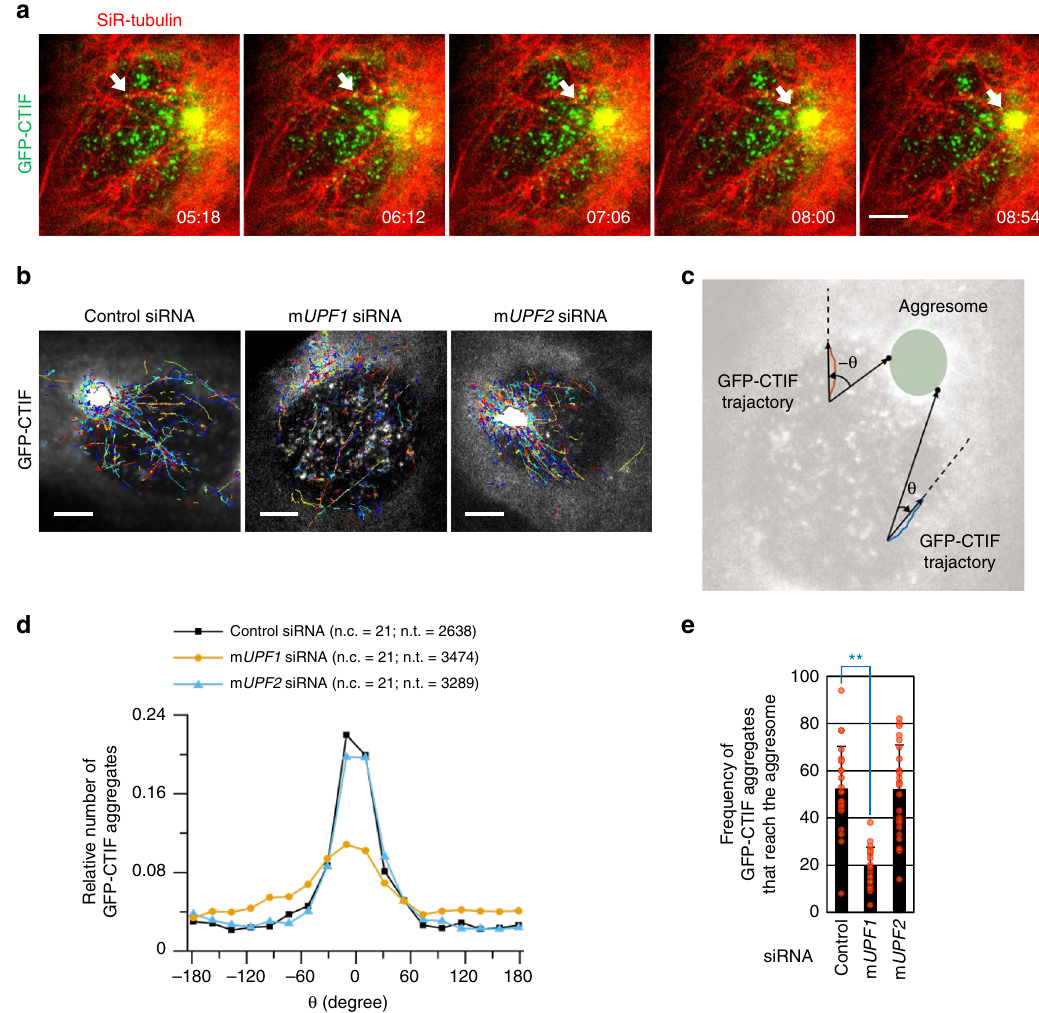
Fig. 6 UPF1 increases the frequency and fi delity of movement of CTIF aggregates. a Live cell imaging of GFP-CTIF (green) with SiR-conjugated tubulin (red). MEFs were transiently transfected with GFP-CTIF and were treated with SiR-tubulin for staining of microtubules. Then, the cells were visualized by line-scan confocal microscopy. Scale bar, 5 μ m; n = 3. b GFP-CTIF aggregates moving toward the aggresome after downregulation of mouse (m) UPF1 or mUPF2. MEFs were transfected with m UPF1 siRNA, m UPF2 siRNA, or nonspeci fi c control siRNA. One day later, the cells were transiently transfected with GFP-CTIF. Two days later, the cells were treated with MG132 and visualized by line-scan confocal microscopy. The trajectories of individual GFP-CTIF aggregates that moved over 590 nm are depicted. Scale bar, 5 μ m; n = 3. c The degree of the migration direction of individual GFP-CTIF aggregates with respect to the aggresome. We fi rst determined the brightest position corresponding to the aggresome periphery closest to the GFP-CTIF aggregates of interest. Then, we measured the angle between the linear trajectory of the GFP-CTIF and a line connecting the brightest position with the initial point of the trajectory of GFP-CTIF. d The distribution of the observed angle values of individual GFP-CTIF aggregates. The number of the cells at each angle was normalized to the total number of the cells analyzed. The number of cells (n.c.) were 21 from three independent experiments for all cases and the number of trajectories (n.t.) were 2638 (Control siRNA), 3474 (m UPF1 siRNA), and 3289 (m UPF2 siRNA), respectively. e The frequency of GFP-CTIF aggregates that reach the aggresome. The number of GFP-CTIF aggregates (per cell) that reached the aggresome during 15 s were counted. Data are presented as mean values ± SD. Two-tailed, unequal-sample variance Student ’ s t test was carried out to calculate the P values. ** P < 0.000. The exact P values are provided in a Source Data File; n = 23 (Control siRNA), 22 (m UPF1 siRNA), and 25 (m UPF2 siRNA) cells from three independent experiments were examined; Source data are provided as a Source Data number of migrating GFP-CTIF aggregates at the same time, we (Fig. 6e), without affecting the translocation rate (Supplementary de fi ned the degree of directional motion of GFP-CTIF aggregates Fig. 11b). Of note, neither mUPF1 nor mUPF2 downregulation toward the aggresome as an angle ( θ ) between the direction of affected the organization of microtubule and MTOC, whereas movement of the GFP-CTIF aggregates and the location of the treatment with the microtubule-depolymerizing drug nocodazole aggresome periphery (Fig. 6c). The results revealed that the almost completely disrupted microtubule organization without distribution of the angle values was drastically spread out in the affecting MTOC (Supplementary Fig. 12). Thus, taken together, mUPF1-depleted cells, in comparison with undepleted or these results suggest that UPF1 promotes the formation of mUPF2-depleted cells (Fig. 6d). Furthermore, downregulation aggresome containing misfolded polypeptides at two distinct of mUPF1, but not mUPF2, signi fi cantly decreased the frequency steps: it facilitates ef fi cient formation of the CED complex of movement of GFP-CTIF aggregates toward the aggresome containing misfolded polypeptides (Fig. 5) and ensures proper